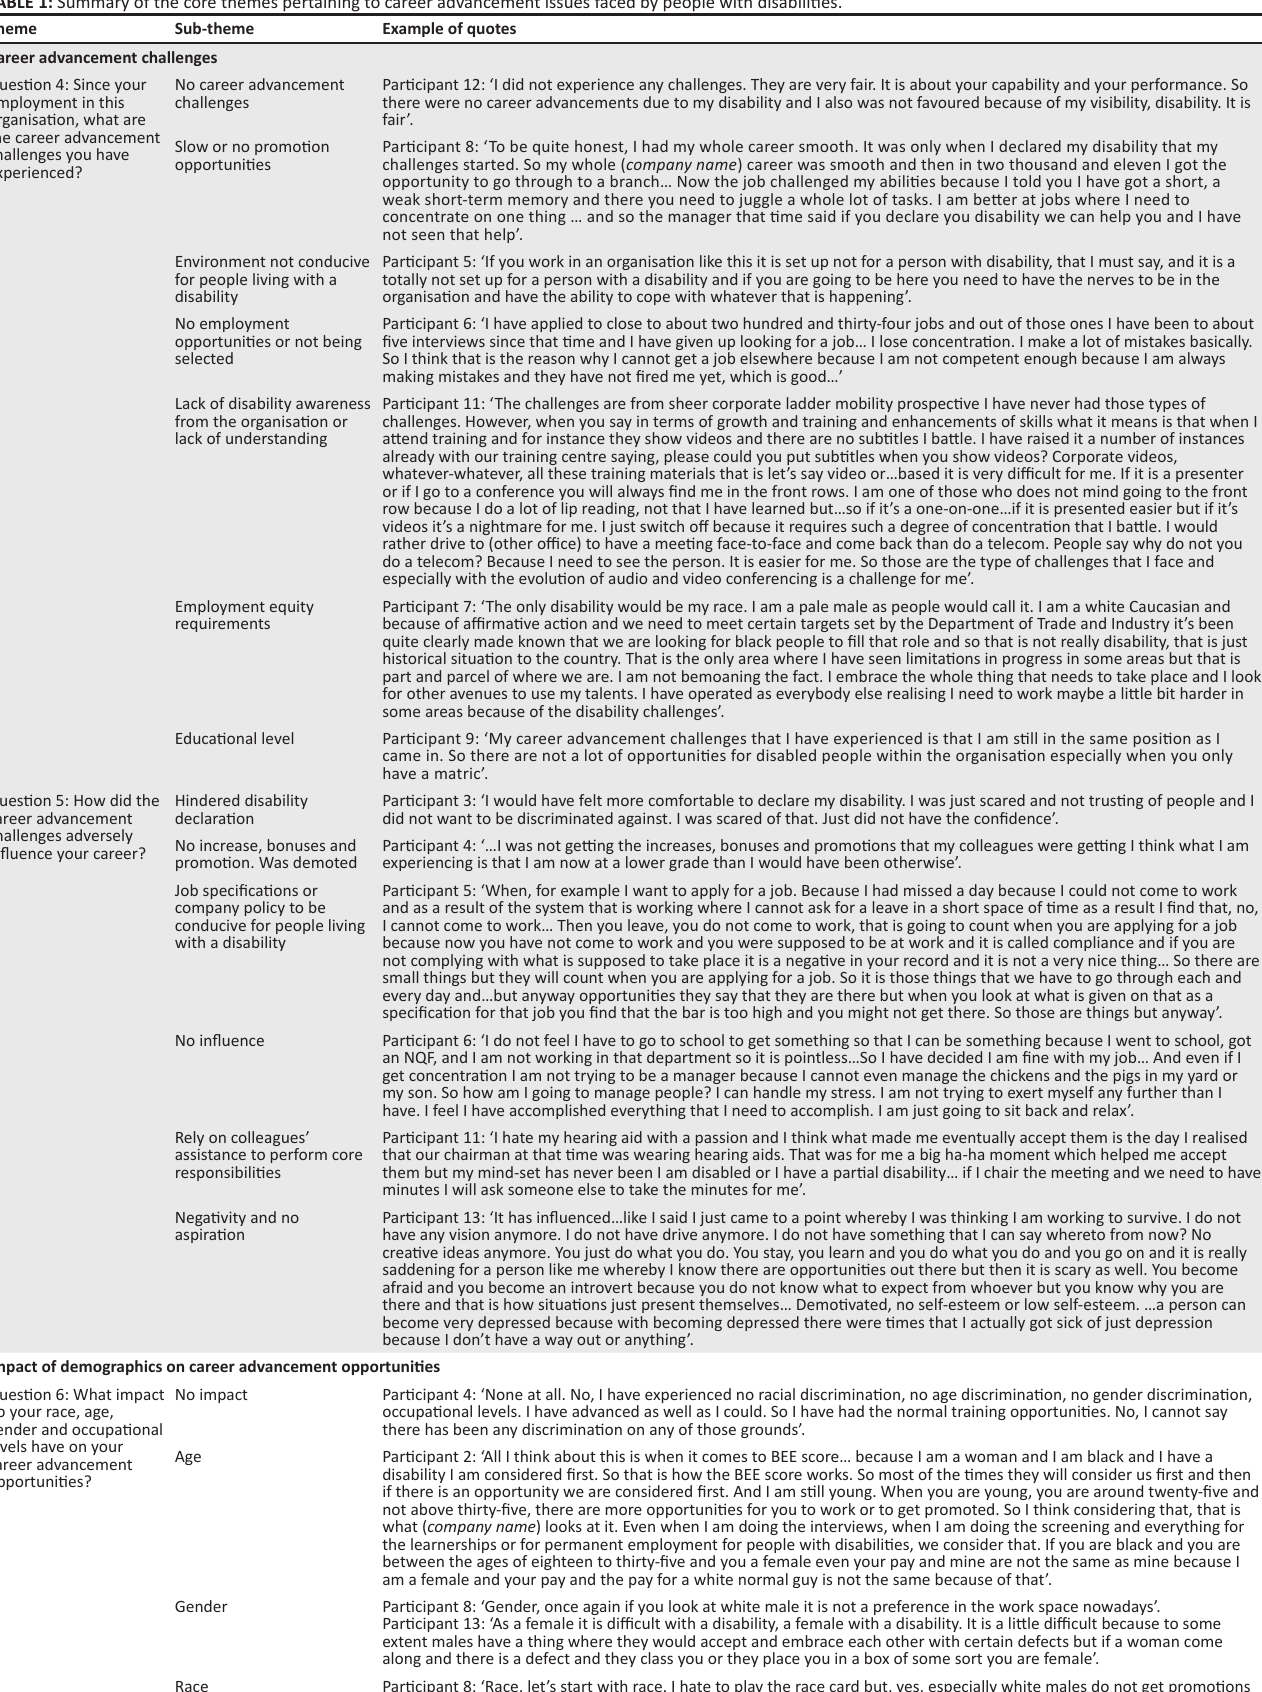
TABLE 1: Summary of the core themes pertaining to career advancement issues faced by people with disabilities.